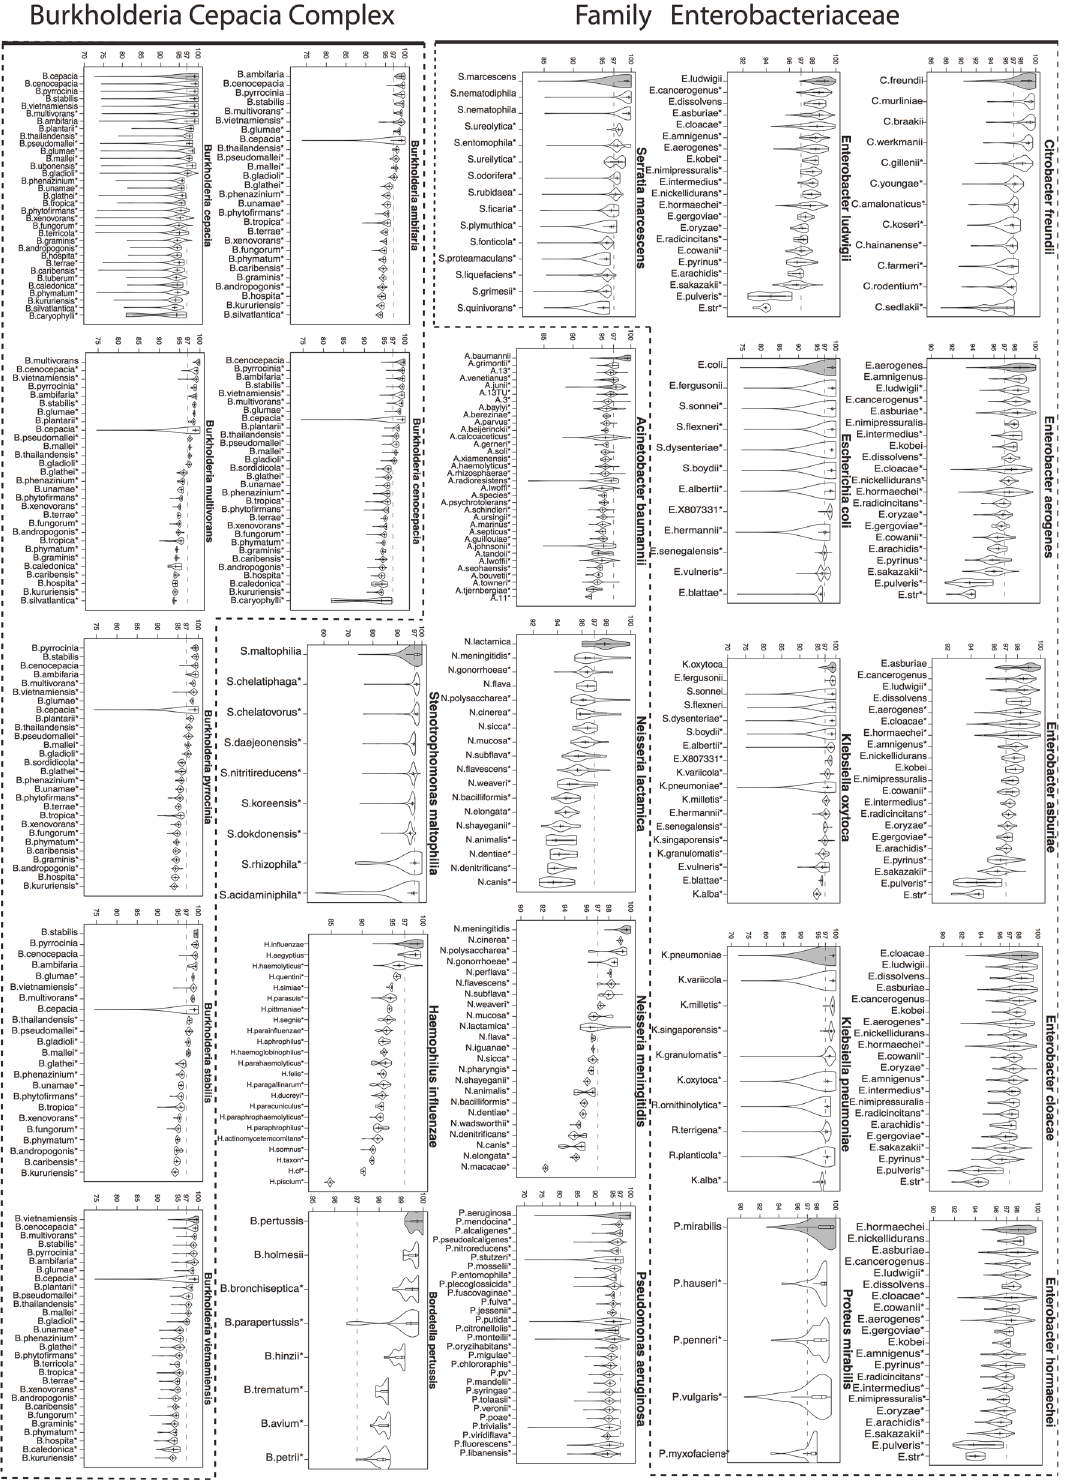
Fig 4. 16S rRNA percent identity within and between species (gram-negative bacteria). Distributions (shown as violin plots) of 16S rRNA percent identity (y-axis of each figure) of pairs of training set sequences belonging to the same (gray) and different species for select gram-negative bacteria. 97% identity, the traditional species level cutoff, has been marked for reference. Species for which sequence variability between sequences from the same species was significantly higher than between those from different species are marked with a * (Wilcoxon test one-sided p-value < 0.0001).